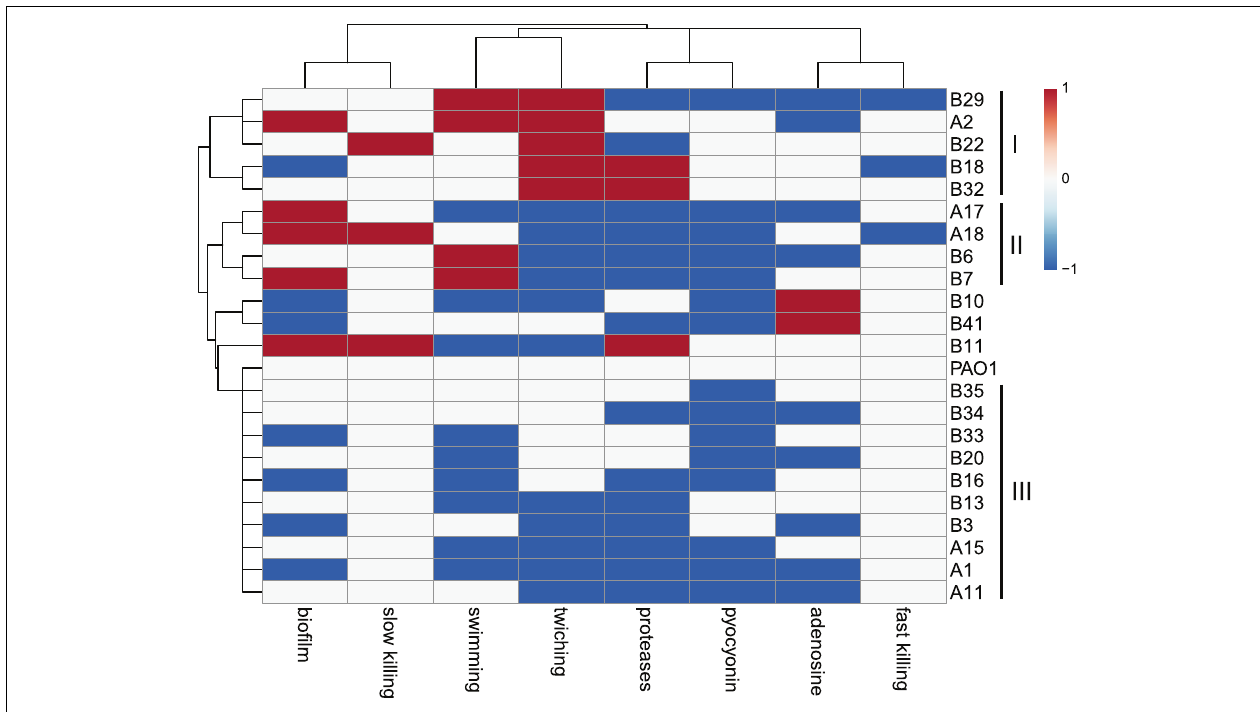
FIGURE 3 | Phenotypic profiling of P. aeruginosa COPD isolates compared with PAO1. Heatmap was generated by setting a significantly ( p < 0.05) enhanced phenotype as “1” (red), decreased as “ − 1” (blue), and no significant change as “0”